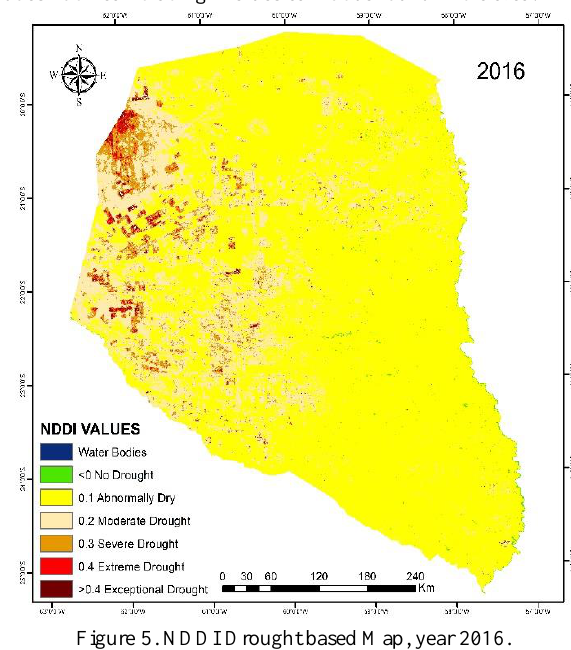
Figure 6. Exceptional Drought values geographical